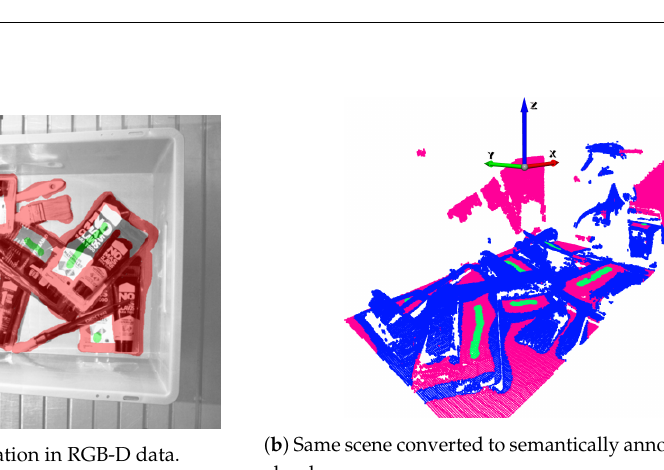
Figure 7. Gripper annotations in a RGB-D orthographic heightmap.